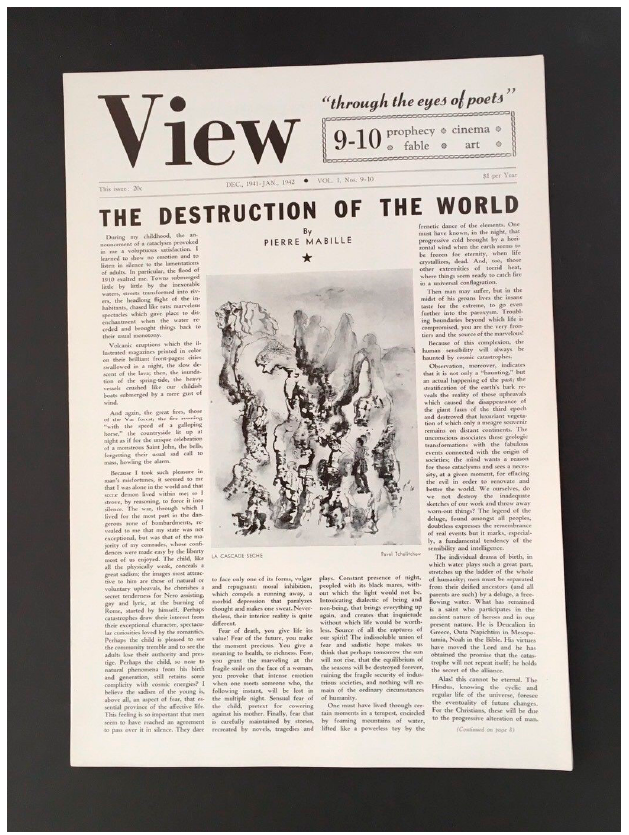
Figure 3. Pavel Tchelitchew , La Cascade Sèche , View , January 1942. In public domain.